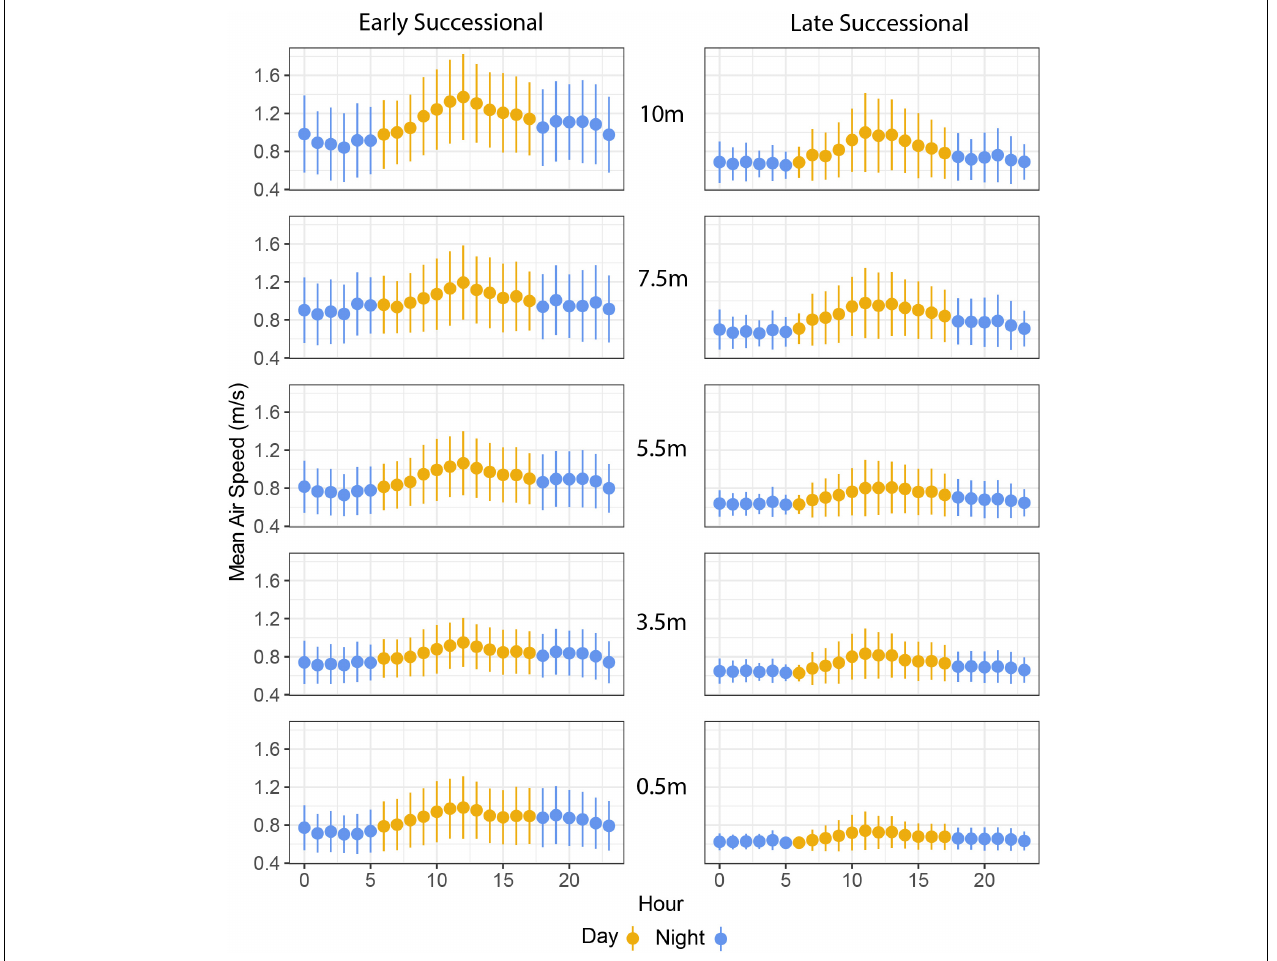
FIGURE 4 | Mean air speeds at two forest sites as a function vertical height and diel periodicity. The x -axis begins at 00:00 h (midnight) and ends at 23:00 h (11:00